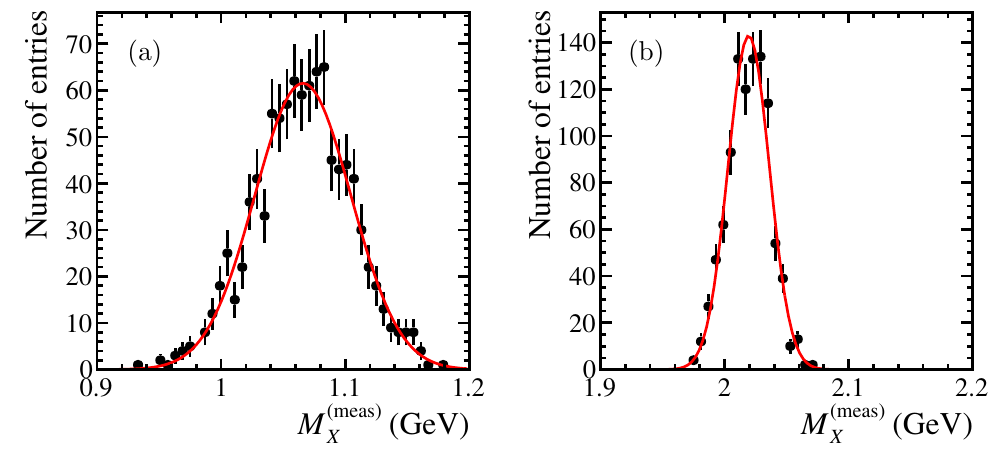
! AX decays of each (cid:13)avour. s